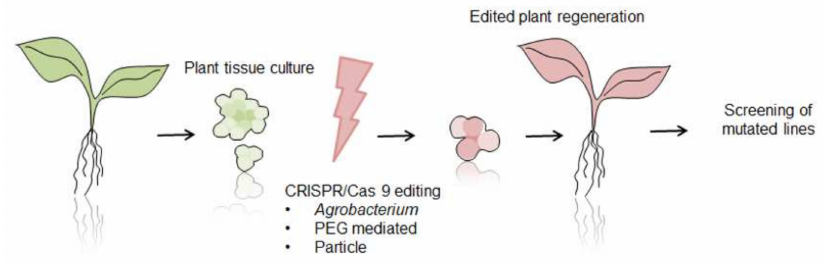
Figure 3. Schematic overview of plant genome editing with CRISPR/Cas9 tool. After obtaining tissue culture from a plant of interest, compounds of CRISPR/Cas9 construct are delivered through Agrobacterium , PEG or particle bombardment. In the next step selection of mutated lines, regeneration and screening of mutated plants are